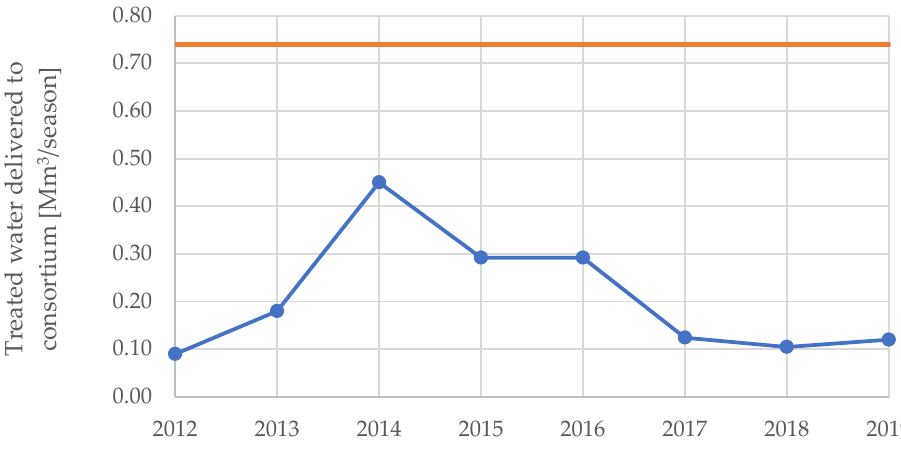
Figure 4. Comparison of actual (blue) and expected (orange) amounts of treated wastewater delivered to the irrigation consortium from 2012 to 2019.